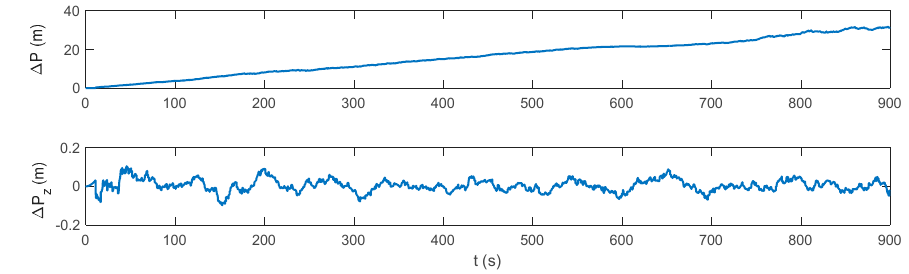
Figure 5. Position error of the INS/DVL-integrated navigation system.